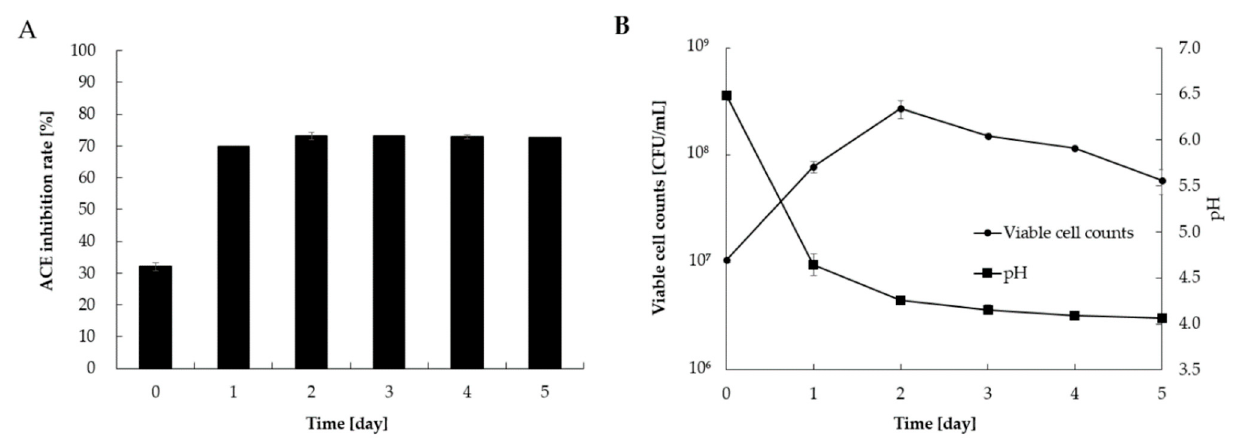
Figure 1. Angiotensin-converting enzyme (ACE) inhibition rate ( A ), and viable cell counts of L. casei 001 and pH ( B ) of L. casei 001-fermented Hidakakombu. (Final concentration: 0.83 [mg/mL]) (mean ± standard deviation (SD), n = 4).